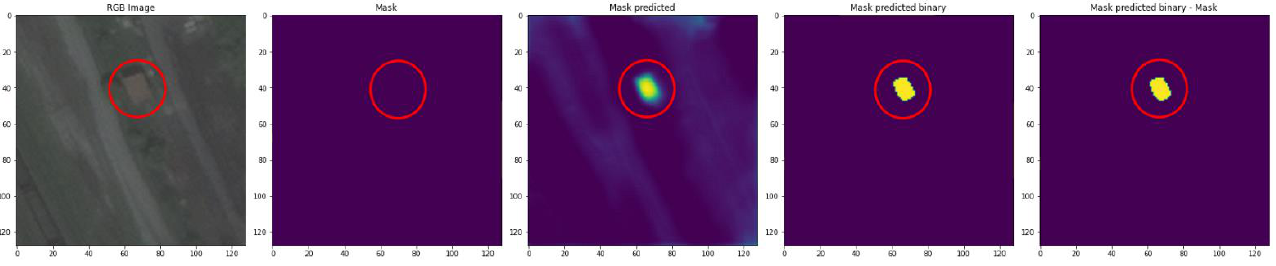
Figure 22. Correctly identified objects that were not in the training set—Zrenjanin.